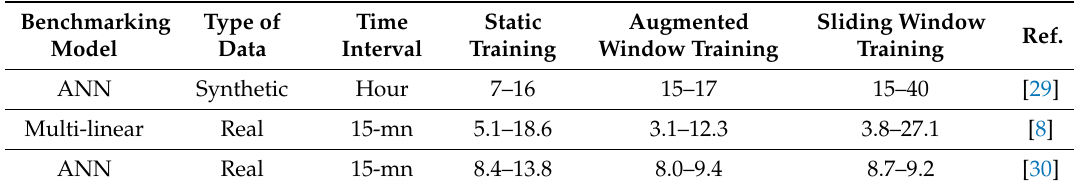
Table 2. Performance metric, coe ffi cient of variance of root mean squared error (CV(RMSE)) in percent (%), of predictions over the testing data set using adapting benchmarking